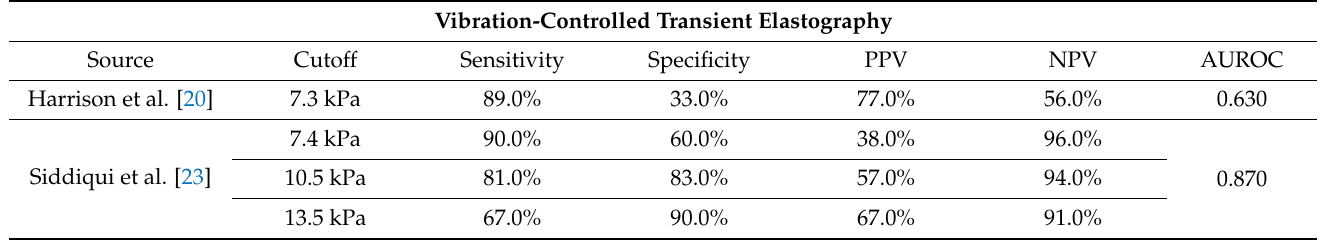
Table 4. Diagnostic accuracy of imaging techniques for significant fibrosis.